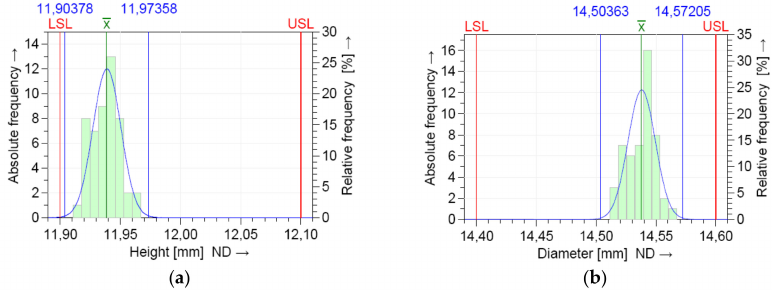
Figure 8. Histogram of the individuals and the distribution model for short term capability study: ( a ) height (H); ( b ) diameter (D).